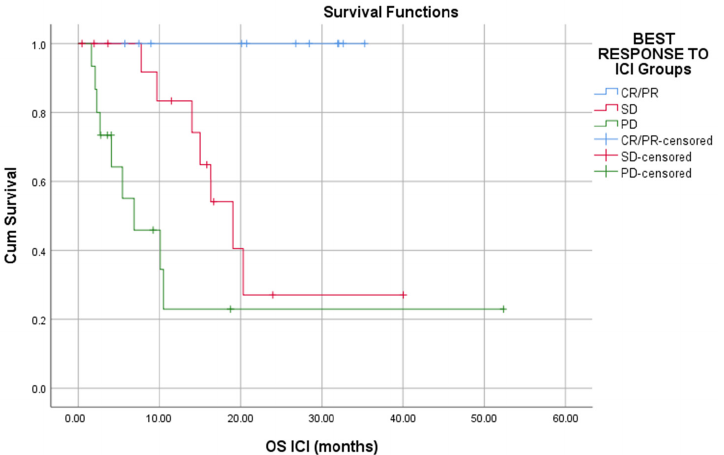
Figure 1. Responders to ICI have better overall survival as compared to that of nonresponders ( p < 0.01).